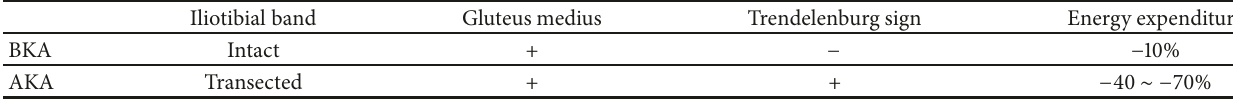
Table 1: Importance of an intact ITB to amputee